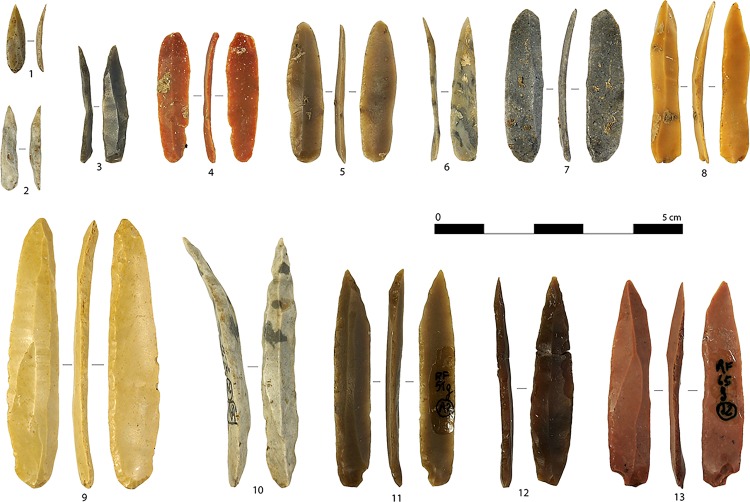
Retouched bladelets with convergent (1–3, 6, 10–13) and lateral (4–5, 7–9) retouch (typological definition after Falcucci et al. [103]).Retouching is direct on 1–3, 6, 10, and 12; alternate on 4–5, 11, and 13; inverse on 7–9 (photo: A. Falcucci).